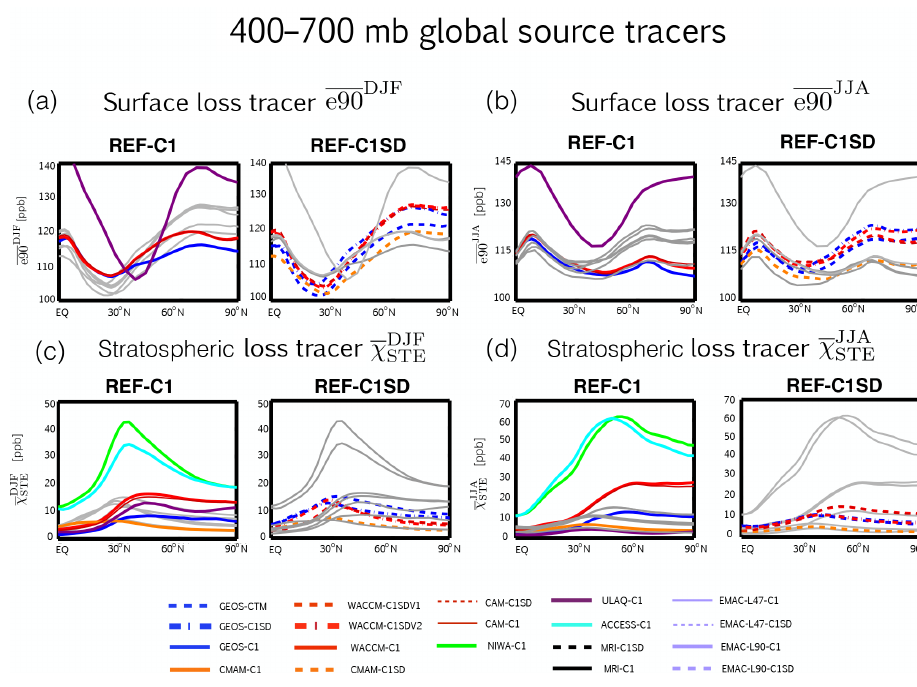
Figure 3. Same as Fig. 2, except for the stratospheric and surface global source tracers, e90 (a, b) and χ STE (c, d) .